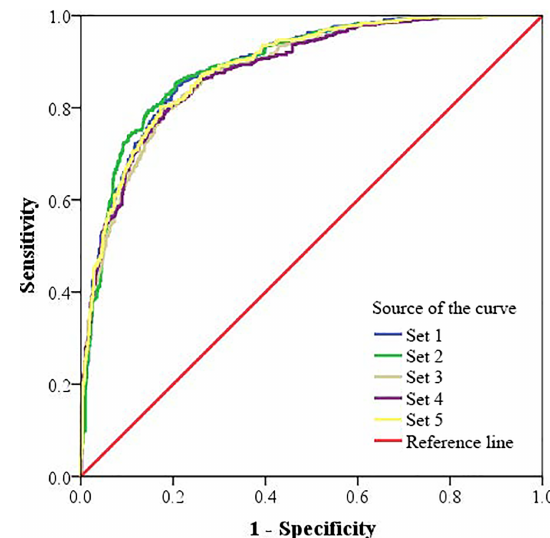
Figure 3. ROC curve of the modeling process. Figure 4. ROC curve of the validation